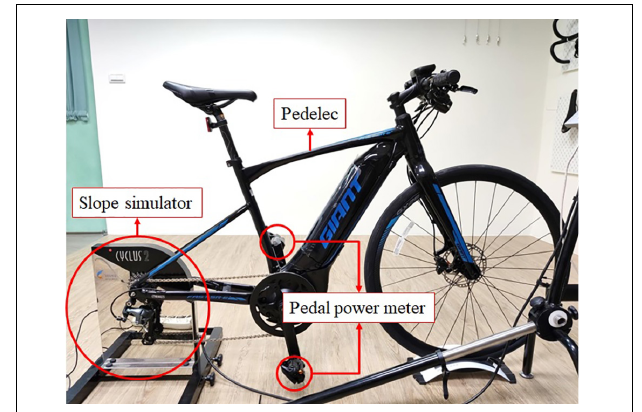
FIGURE 1 | The pedelec, pedal power meter, and the slope simulator.